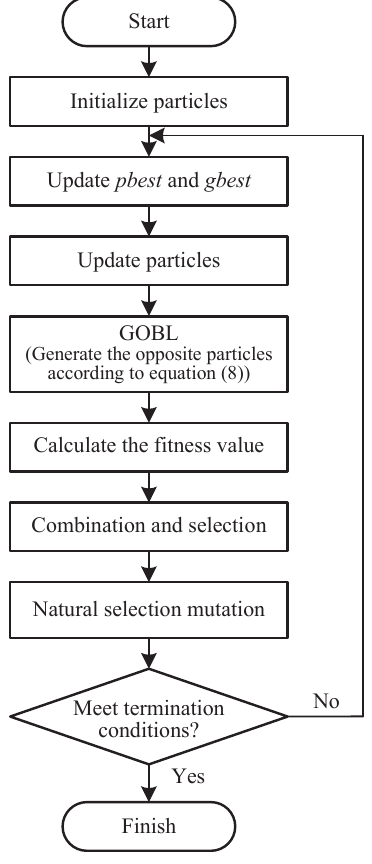
Figure 2. Flow chart of the G-PSO